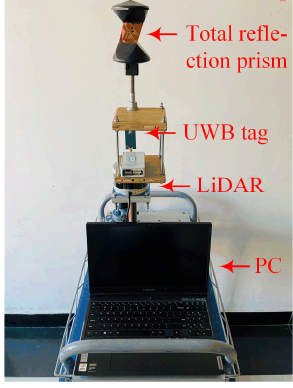
Figure 5. Experimental platform. Table 1. Specifications of the UWB and LiDAR sensors. The mark—means without this property.